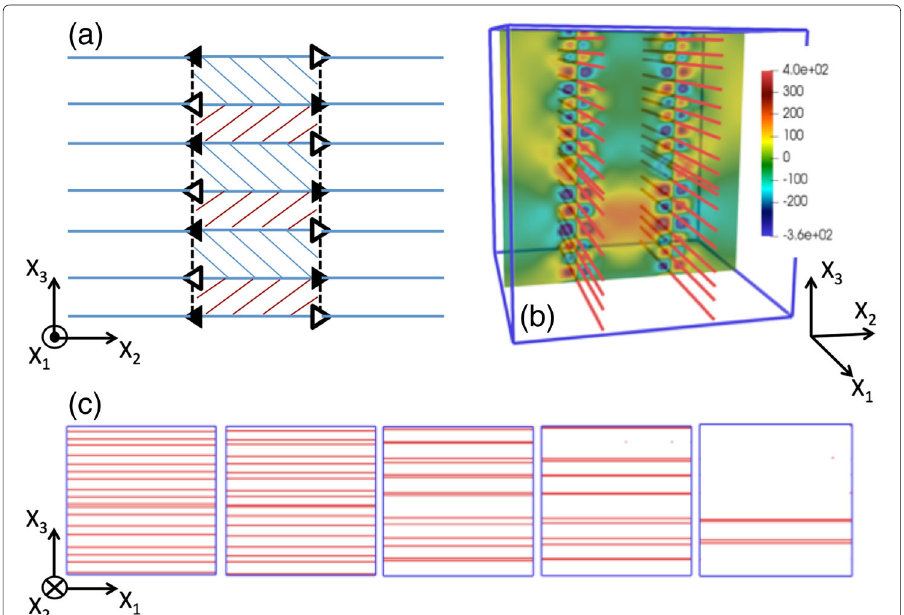
Fig. 3 Self-relaxation of twin stacks. Initial twin stacks are let to self-relax by thickening/thinning of twins in the normal direction. a : sketch of the simulated twin stacks using wedge disclination lines. b : Colour-coded is shown the initial in plane shear stress field (MPa) due to disclination lines (red lines). c View in the ( X 1 , X 3 ) plane showing the progressive growth and shrinkage of twins during self-relaxation until a defect-free matrix is